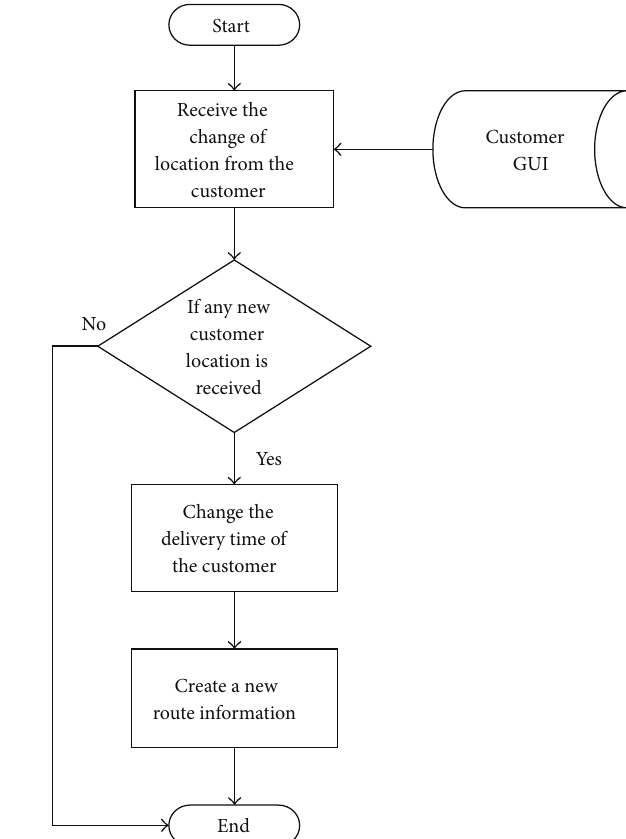
Figure 8: Time change request scenario logic from